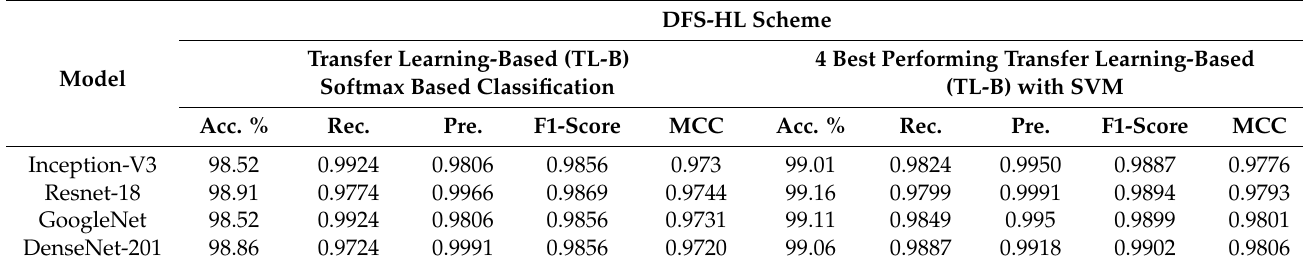
Table 5. Performance comparison of features extracted from custom-made TL-B CNN models